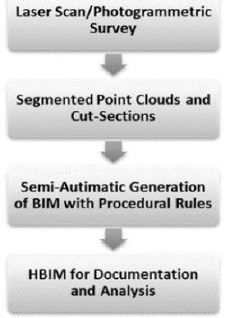
Figure 1. Workflow of as-built BIM modeled on Cultural Heritage site (HBIM), from (Dore et al.